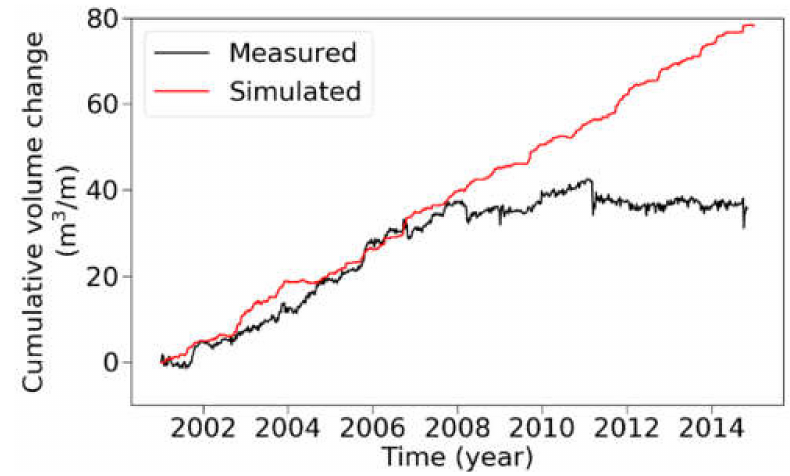
Figure 17. Time series of the measured and simulated cumulative volume changes in the validation